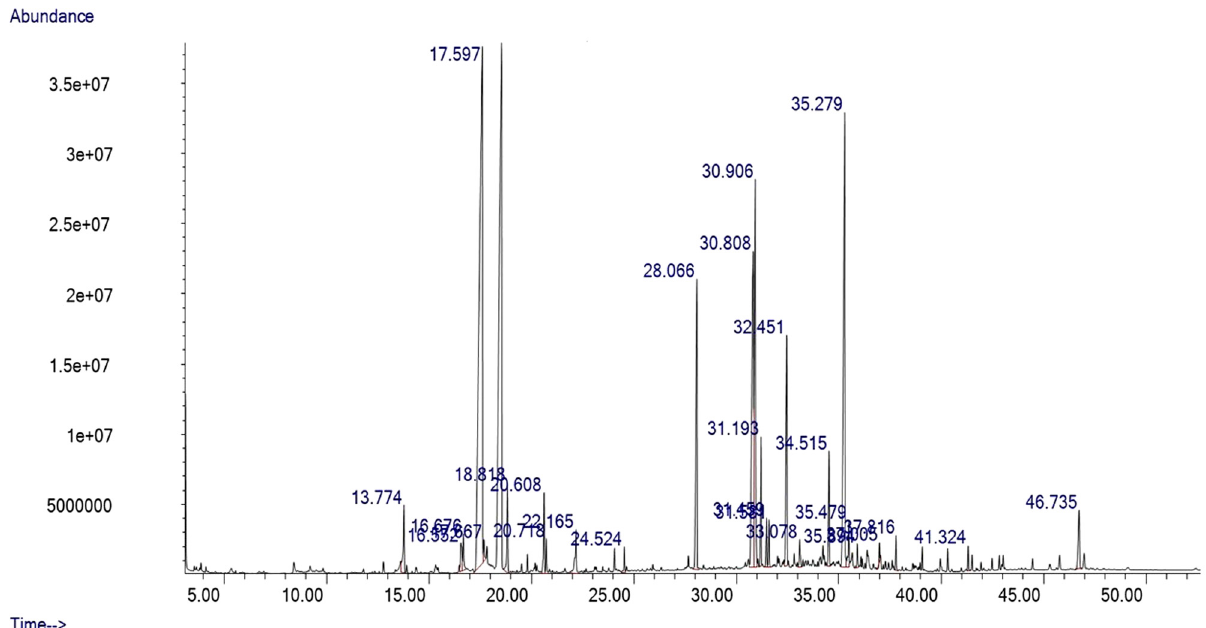
Figure 1: GCMS chromatogram of EO from clove